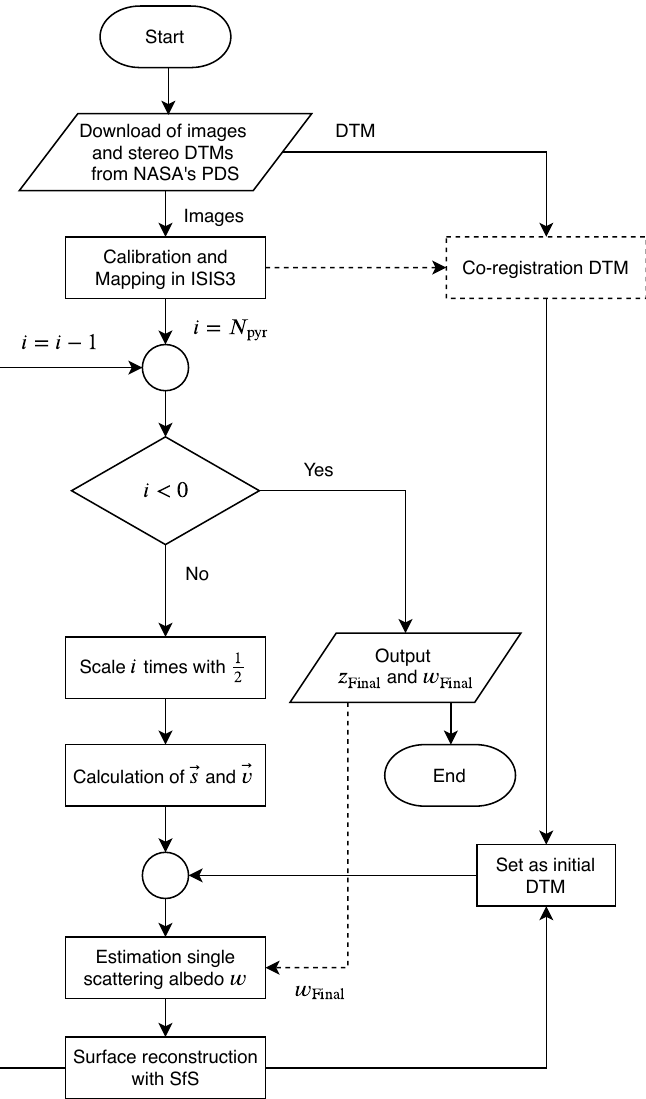
Figure 6. SfS workflow adapted from Grumpe et al. [43]. Dashed lines indicate optional steps that are executed if